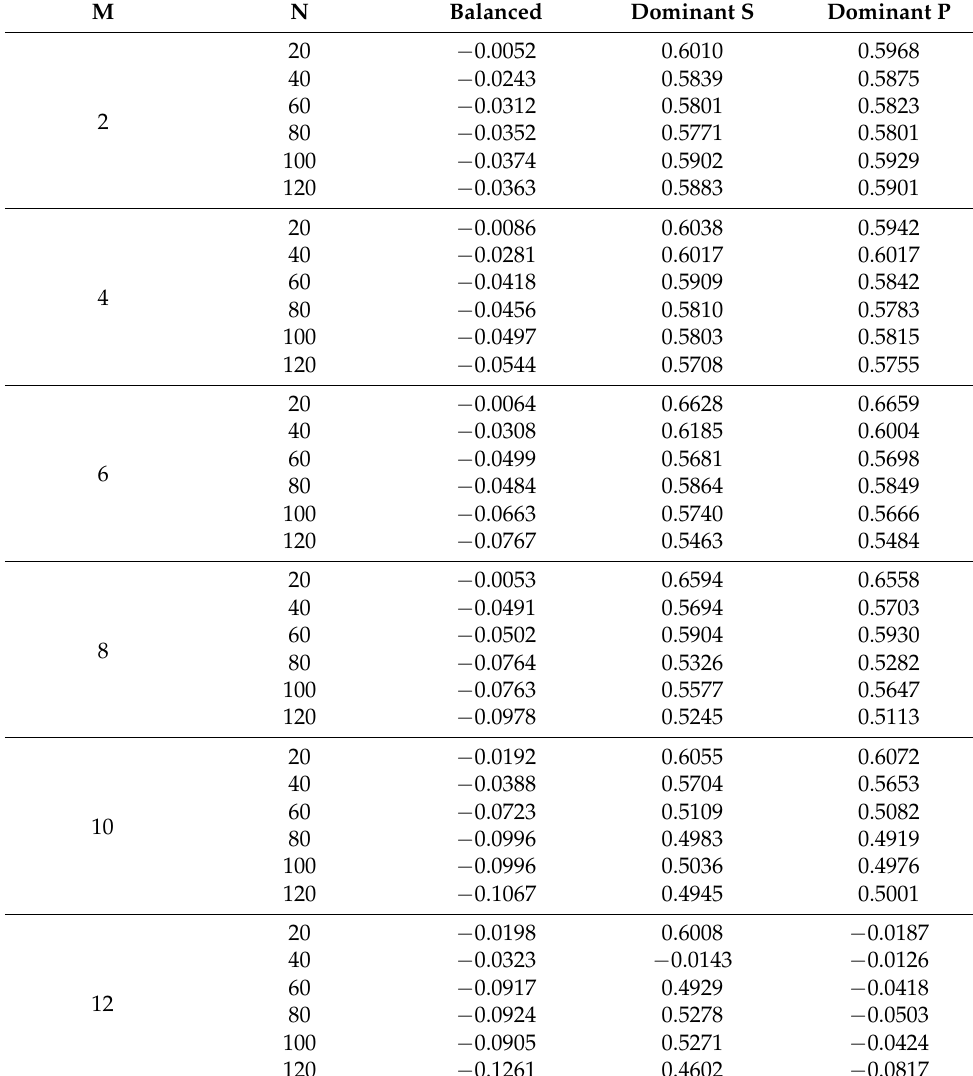
Table 5. Average δ deviation from GA for large